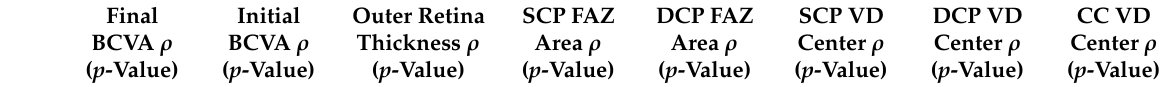
Table 3. Correlations between OCT and OCTA parameters and BCVA in the patients with CSC.